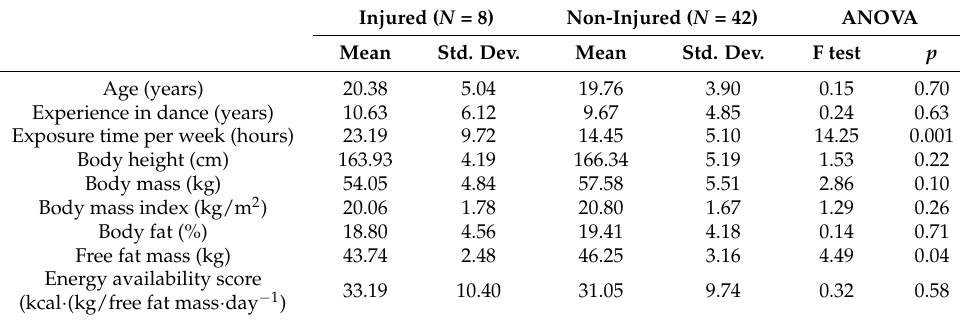
Table 3. Differences between groups based on bone injury